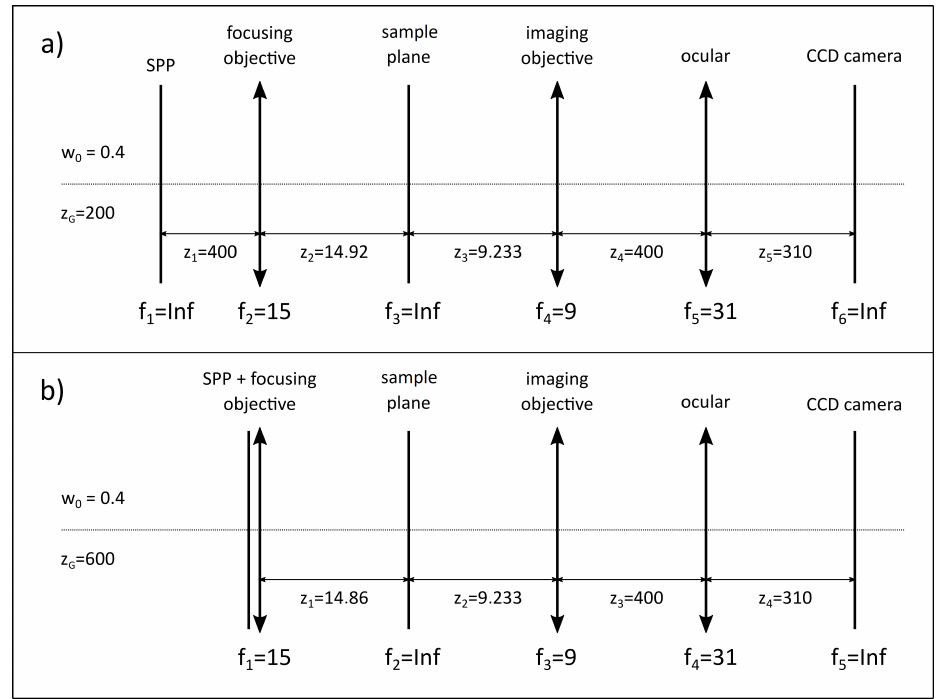
Figure 2. Two versions of the OVSM scheme; ( a ) the SPP is separated from the focusing lens; ( b ) the SPP and focusing objective work together as a single thin element. In both cases the imaging objective and the ocular form the image of the sample plane on CCD camera. Units: